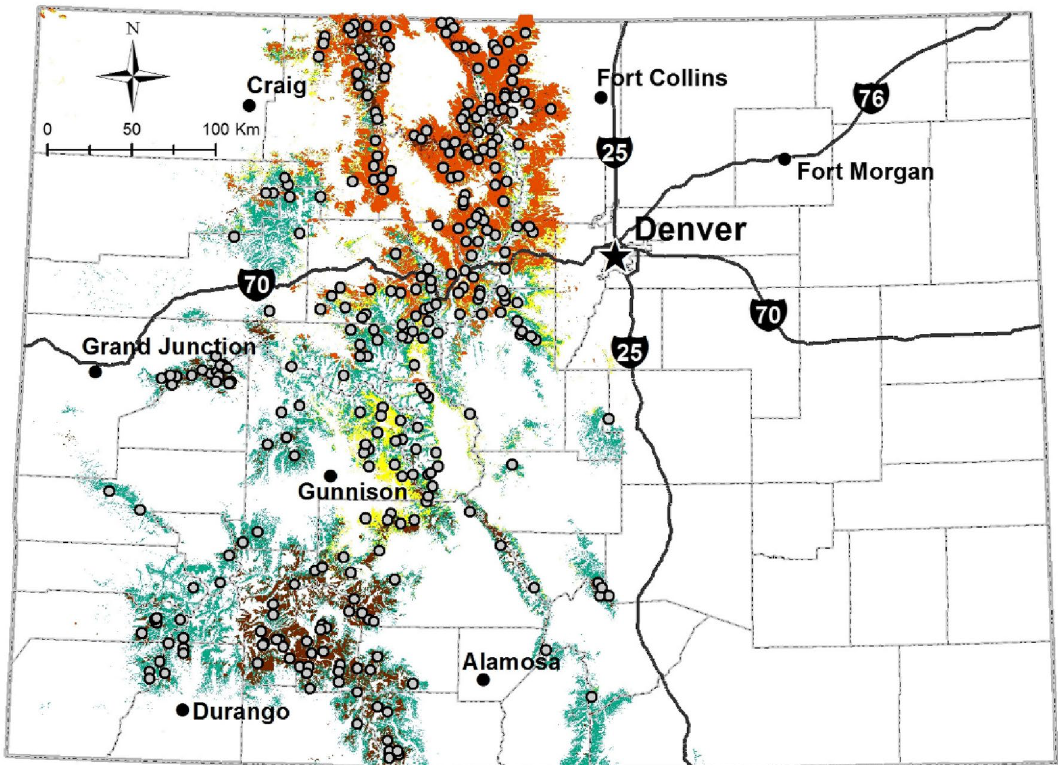
Figure 1. Randomly selected sampling sites (gray circles) where passive infrared game cameras were deployed in spruce-fir (green) and lodgepole pine (yellow) forests in Colorado, USA, 2013-2014. Brown and orange are the approximate extents of spruce beetle and mountain pine beetle impacts in spruce-fir and lodgepole pine forests, respectively, as of 2014. Reprinted from “Mammalian responses to changed forest conditions resulting from bark beetle outbreaks in the southern Rocky Mountains,” by J. S. Ivan, 2018, Ecosphere, 9(8), e02369. Figure produced with ArcMap 10.7 available at: https:// deskt op. arcgis. com/ en/ arcmap/ 10.7/ get- start ed/ setup/ arcgis- deskt op- quick- start- guide.